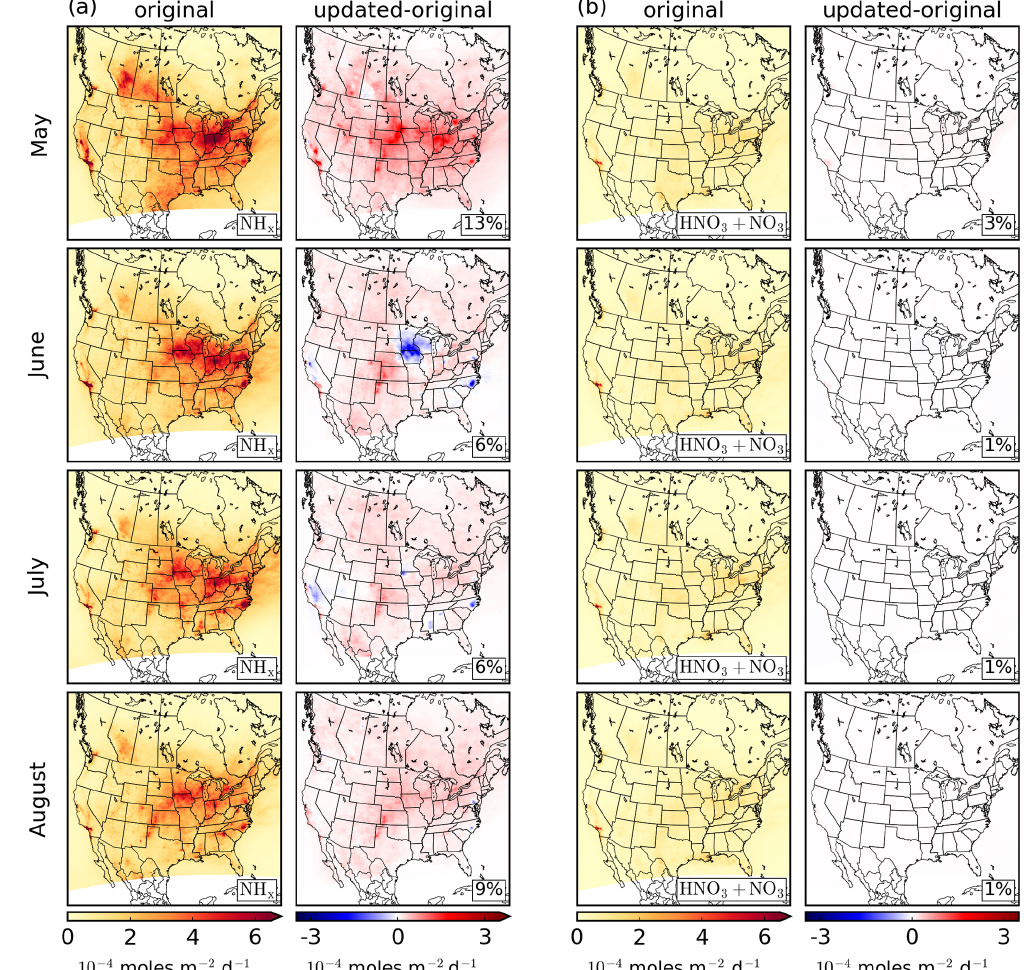
Figure 15. Same as Fig. 5, except for the total (dry + wet) deposition rates of (a) NH x and (b) HNO 3 + NO 3 .